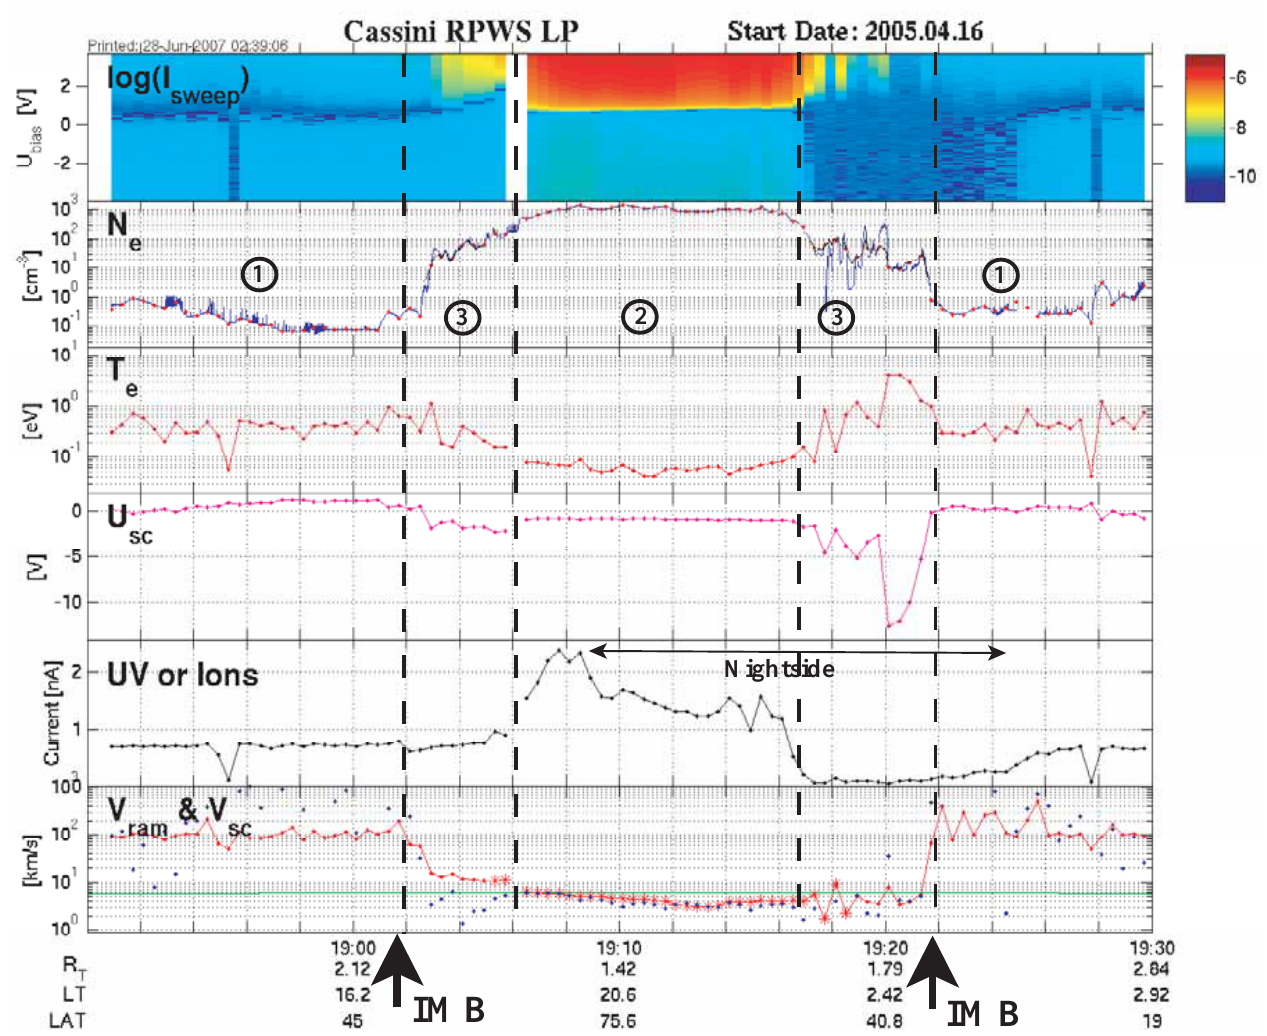
Fig. 3. Overview of the RPWS derived parameters for the T5 flyby. Parameters are calibrated LP sweep data (panel 1); n e (panel 2) from LP sweeps (red dots), LP 20Hz (blue line) and f UH derived density (black line) deduced from Fig. 4; T e (panel 3) from LP sweeps (red dot-line); U SC (panel 4) from LP sweeps; current for LP negative bias voltage (panel 5); and v i (panel 6) from total ion current (blue dots) and slope for negative bias (red dot-line). The induced magnetospheric boundary (IMB) should be close to the outward edge of region 3 (exo-ionosphere). Region 1 is the upstream magnetosphere and region 2 the proper ionosphere. Derived electron temperatures in the magnetosphere (region 1) are most probably due to the spacecraft photoelectrons and are not representing the true magnetospheric electron temperatures. Shown with arrows is the approximate position of the induced magnetospheric boundary